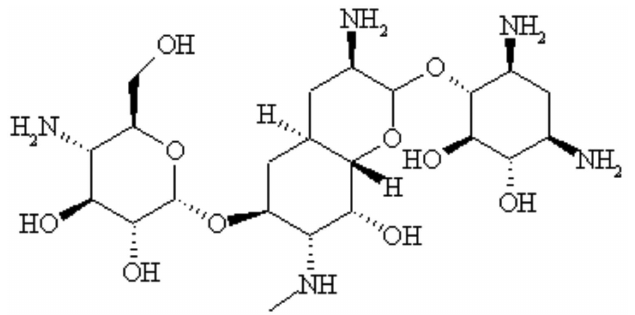
FIGURE 1 - Chemical structure of